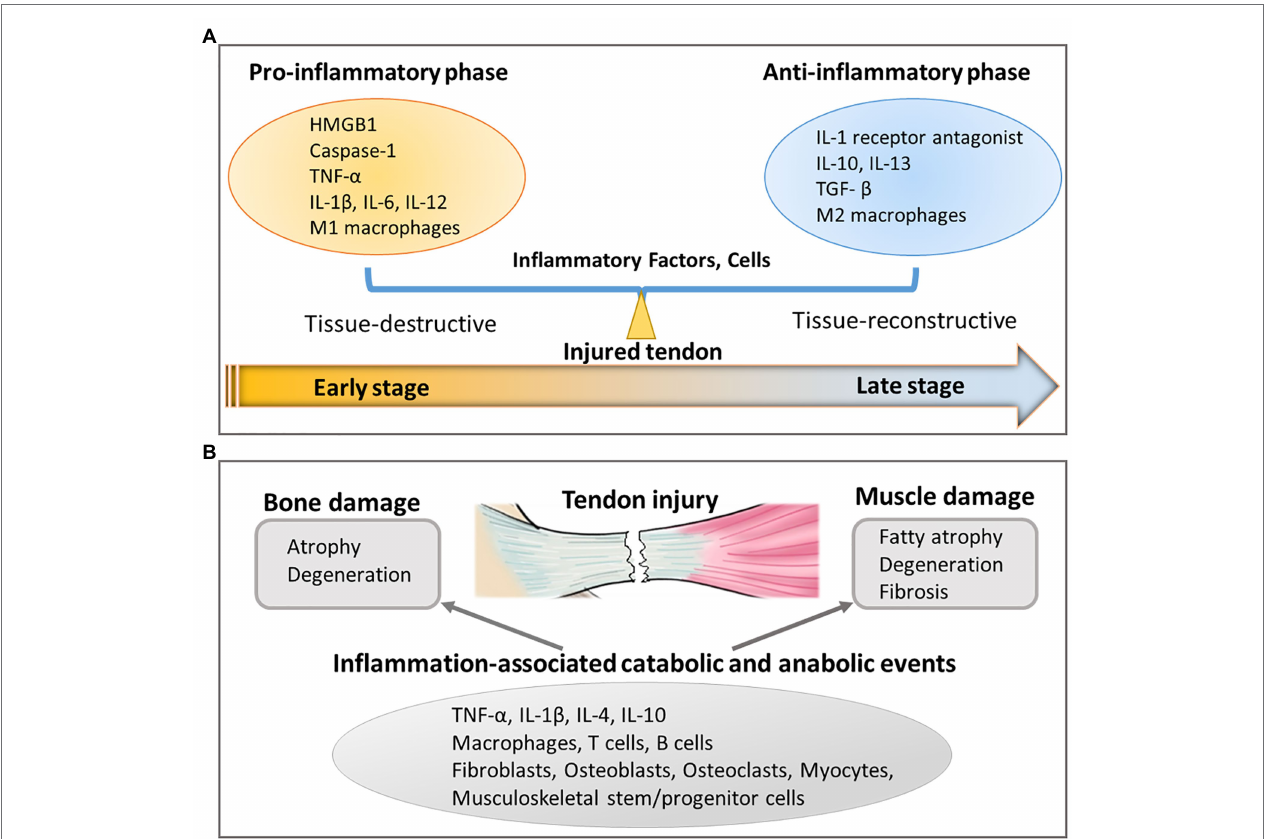
FIGURE 3 | Inflammation-related responses resulting from tendon injury. (A) Unbalanced pro-inflammatory and anti-inflammatory response in injured tendon affects tendon healing by secreting inflammatory factors and cells. (B) Tendon injury also leads to bone and muscle damage through inflammation-associated catabolic and anabolic